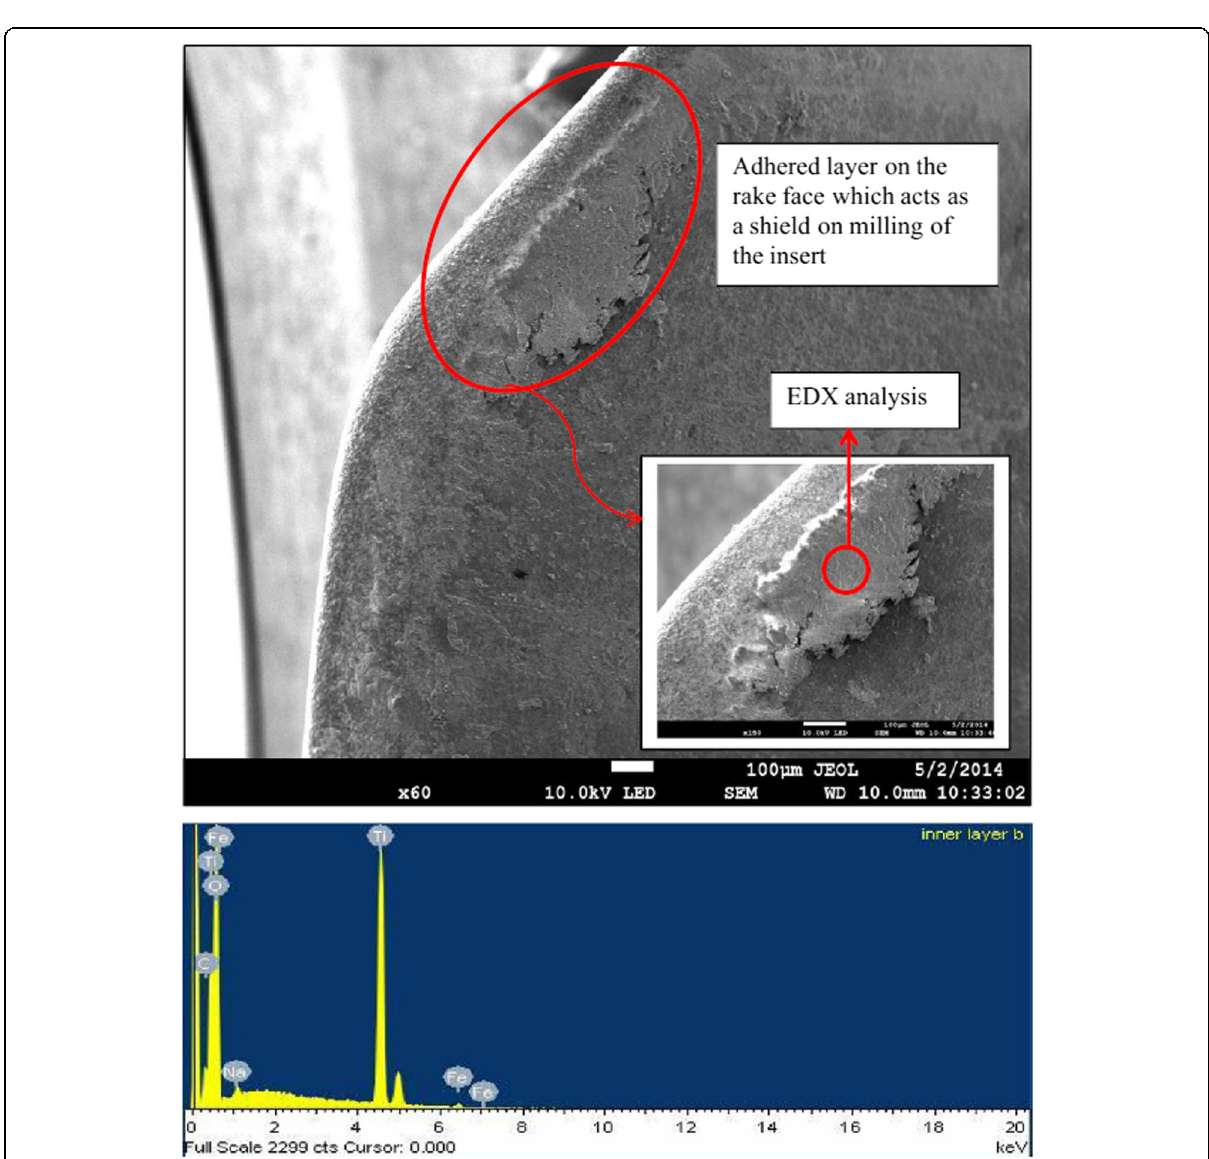
Fig. 12 SEM and EDX of cutting edge [122]. At a cutting speed of 1500 rpm, feed rate of 0.02-mm tooth, and axial depth of 0.1 mm using nanoparticle-based coolant at a cutting distance of 180 mm (×60 magnification). Reproduced with permission from